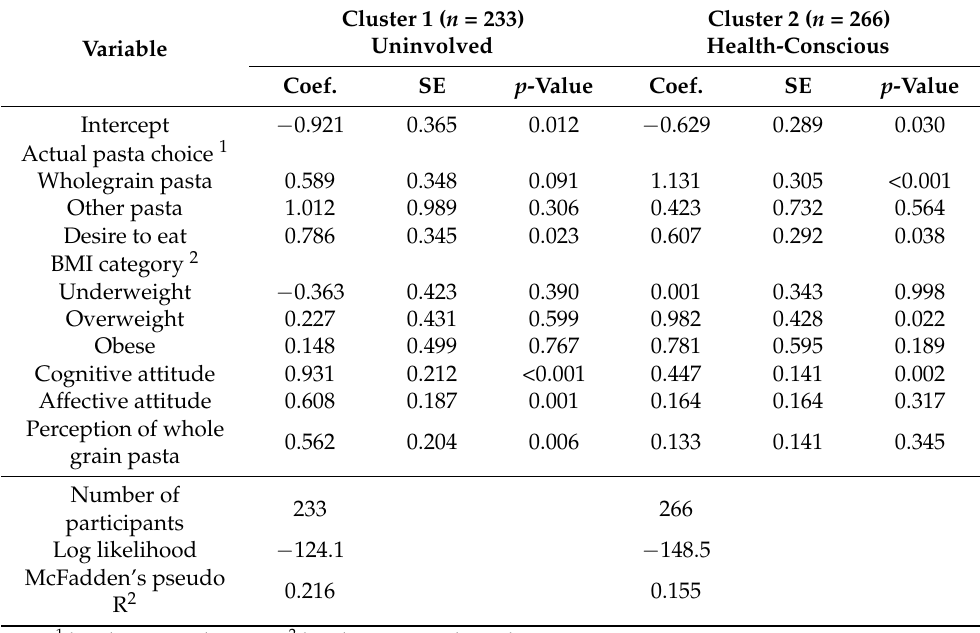
Table 4. Factors determining willingness to include wholegrain pasta in the